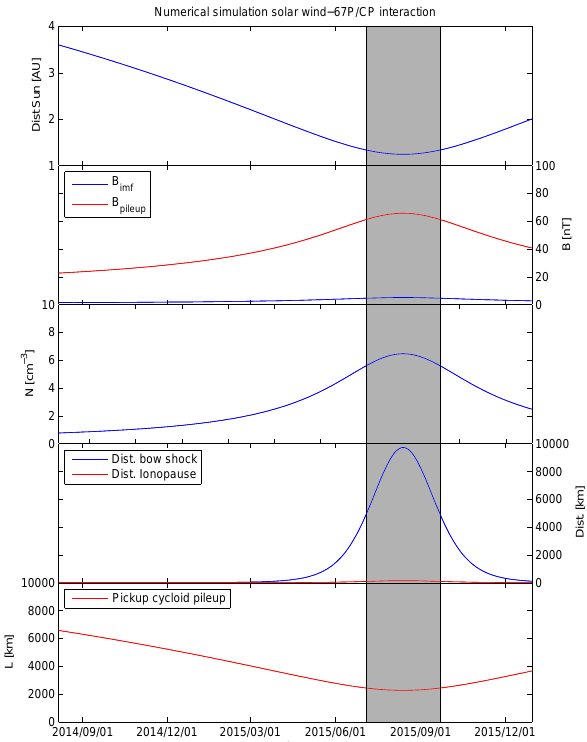
Figure 17. The time development of various parameters around Fig. 17. The time development of various parameters around comet 67P/CG obtained from the model by comet 67P/CG obtained from the model by Koenders et al. (2013): Koendersetal.(2013): Thedistancecomet-Sun;themagneticfieldstrengthoftheIMFandthepile-upregion; the ion density; the distance of the bow shock and the ionopause from the comet; the radius of the pick-up the distance comet–Sun; the magnetic field strength of the IMF and cycloidatthepile-upboundary. Thegray-shadedareashowstheintervalduringwhichthecometosheathhasa the pile-up region; the ion density; the distance of the bow shock sizegreaterthan2iongyroradii. and the ionopause from the comet; the radius of the pick-up cycloid at the pile-up boundary. The gray-shaded area shows the interval during which the cometosheath has a size greater than 2 ion gyro